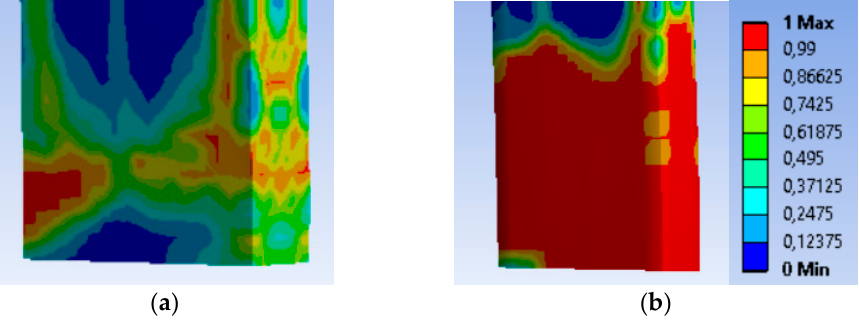
Figure 8. Concrete damage of specimens ( a ) CS-0; ( b ) CS-C2.